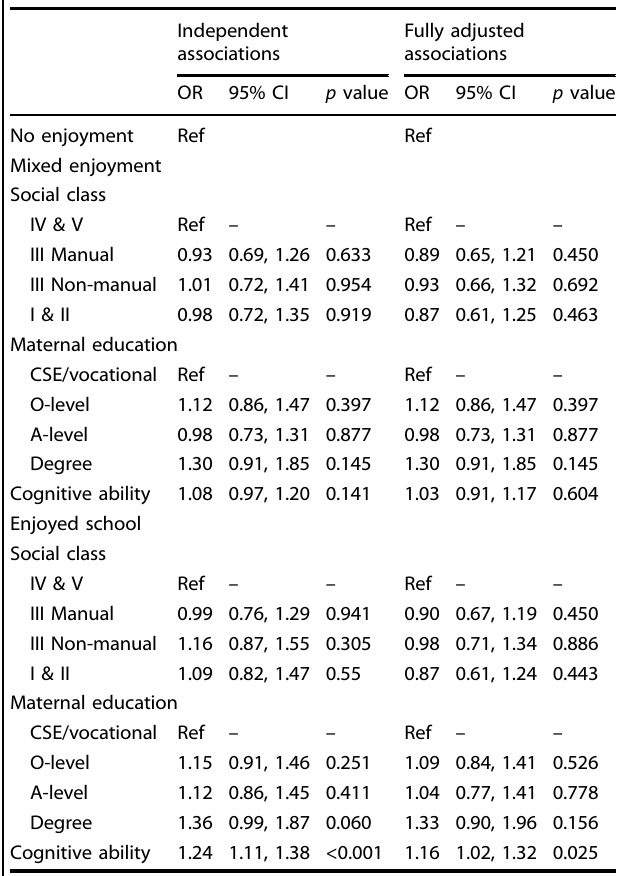
Table 2. Multinomial regression of school enjoyment on key parameters in multiple imputation sample. Full parameter estimates provided in Supplementary Table